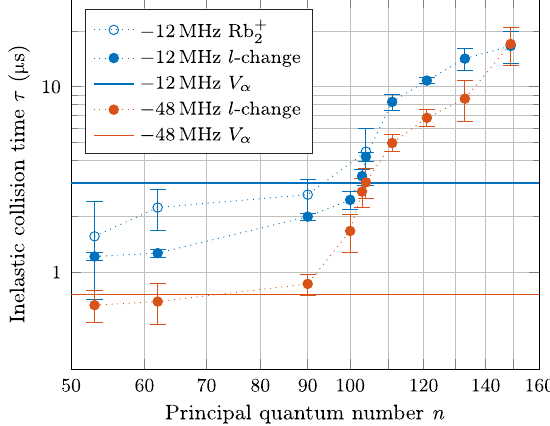
FIG. 9. Comparison between the inelastic collision time (see also Fig. 8) and the collision time of a molecular dynamics simulation of an ion and a neutral atom with the polarization potential V α only. The density for the simulation was chosen such that the density is according to Fermi ’ s density shift [Eq. (1)] with − 10 MHz = ð 10 14 cm − 3 Þ . The classical simulation with pointlike particles reproduces the order of magnitude for the inelastic collision time at low principal quantum numbers. On the one hand, the full quantum treatment including the electron must accelerate this process for lower n , which is very likely due to the butterfly state crossing the nS state. On the other hand, it must slow down the inelastic collision above the threshold region 90 < n < 110 so that collisional lifetimes above 10 μ s are possible even at the peak density of the